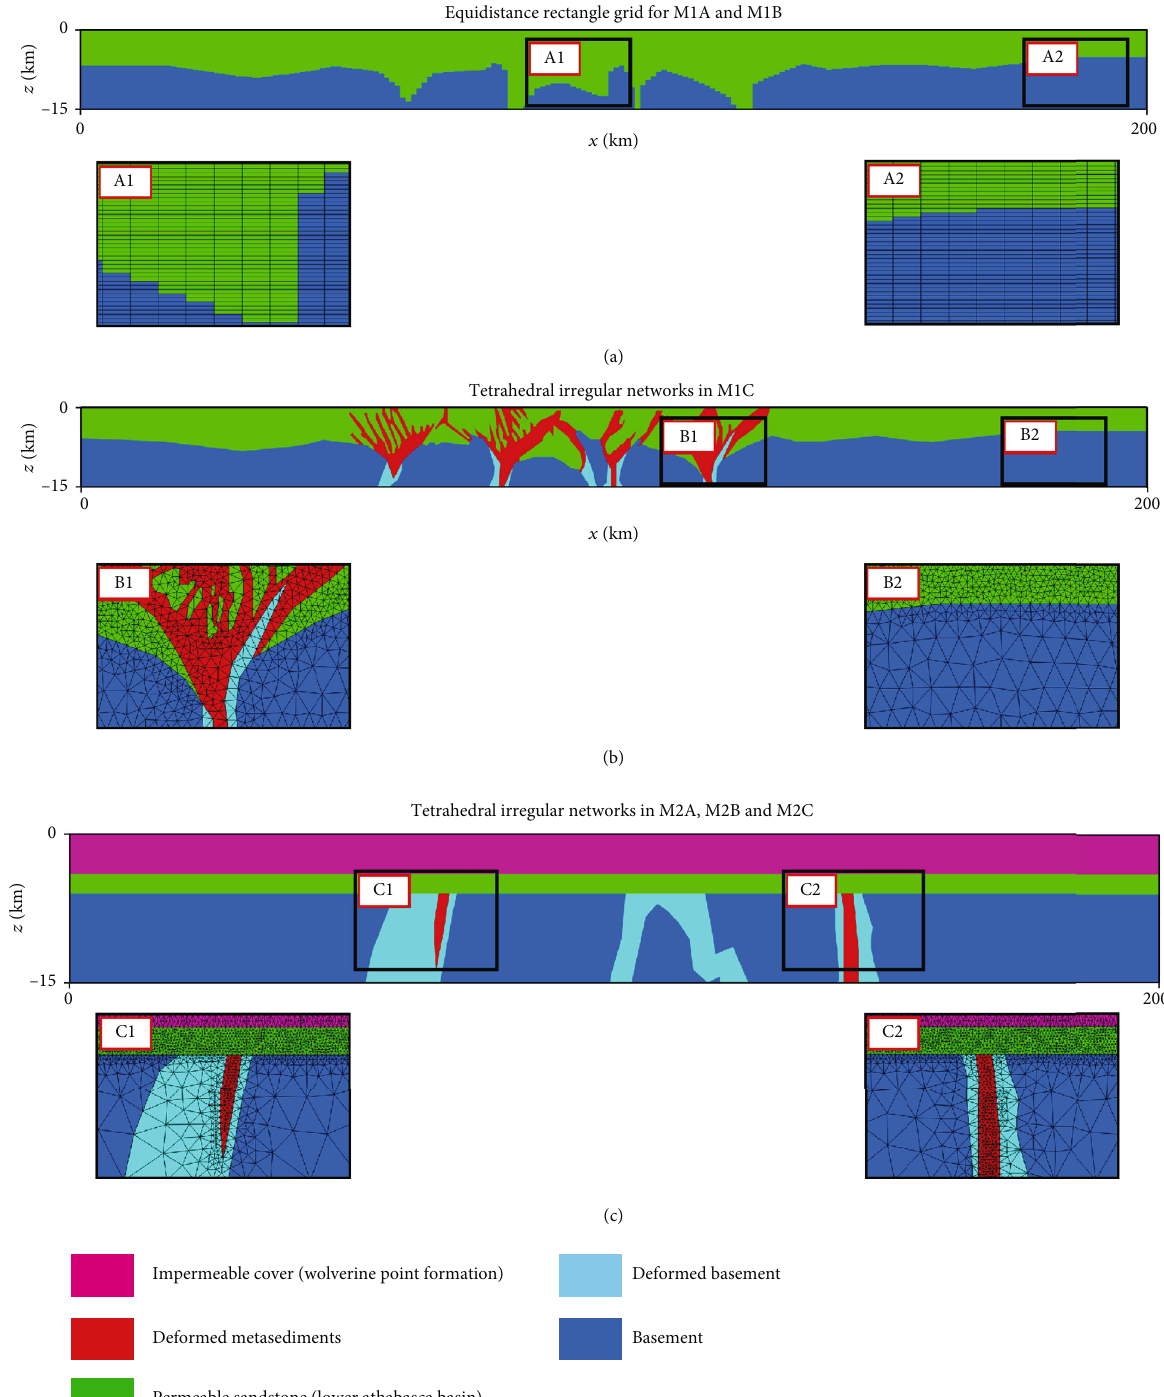
Figure 4: Di ff erent types of grids (Equidistant Rectangle and Tetrahedral Irregular grid) are used for di ff erent models. While Equidistant Rectangle grid is used for simple models (two rock layer models; (a) M1A and M1B), the Tetrahedral Irregular grid is employed to design complex models ((b) M1C and (c) M2A, M2B, and M2C). High-resolution regions are assigned to rock layers such as the basin and deep-seated structures, where hydrothermal activity is expected. Subsequently, low-permeability regions (i.e., the basement and the impermeable cover) are assigned as low